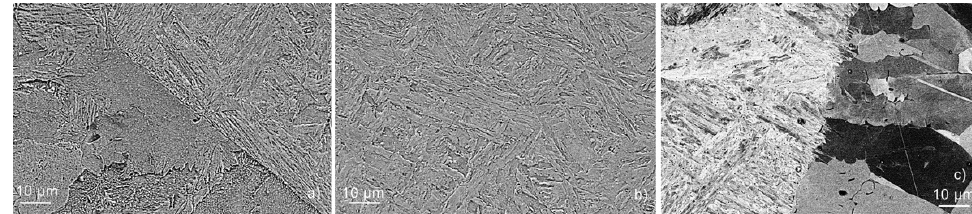
Figure 4. SEM images illustrating the: ( a ) CS side HAZ, the fusion line and the adjacent martensitic structure of the weld; ( b ) weld central region; ( c ) martensite weld structure, fusion line and the HAZ on the SS side.